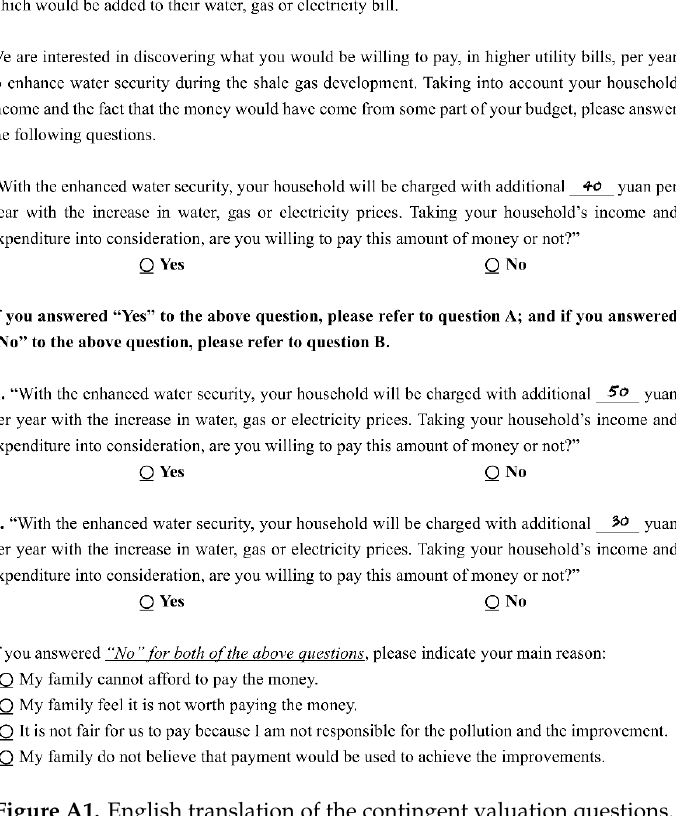
Figure A1. English translation of the contingent valuation questions.